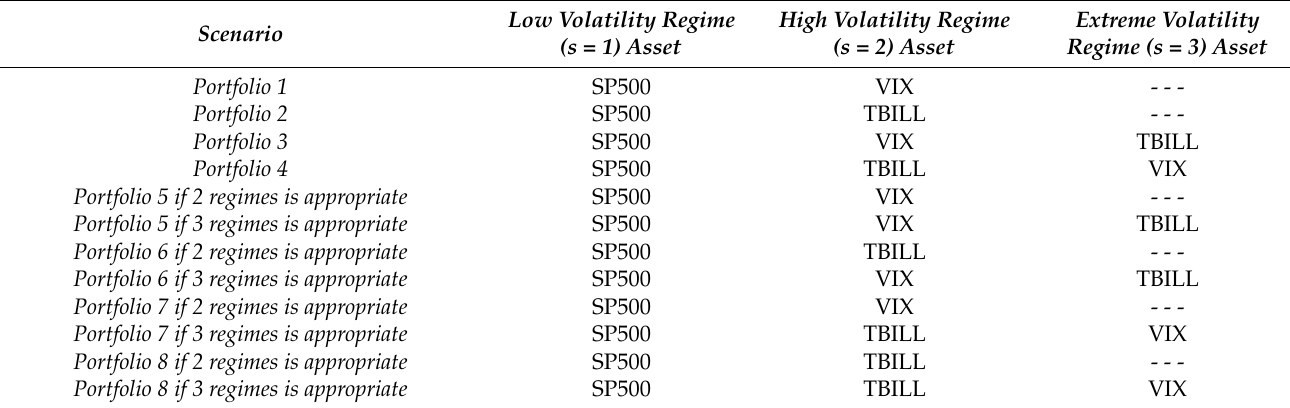
Table 1. The portfolio assets in each investment